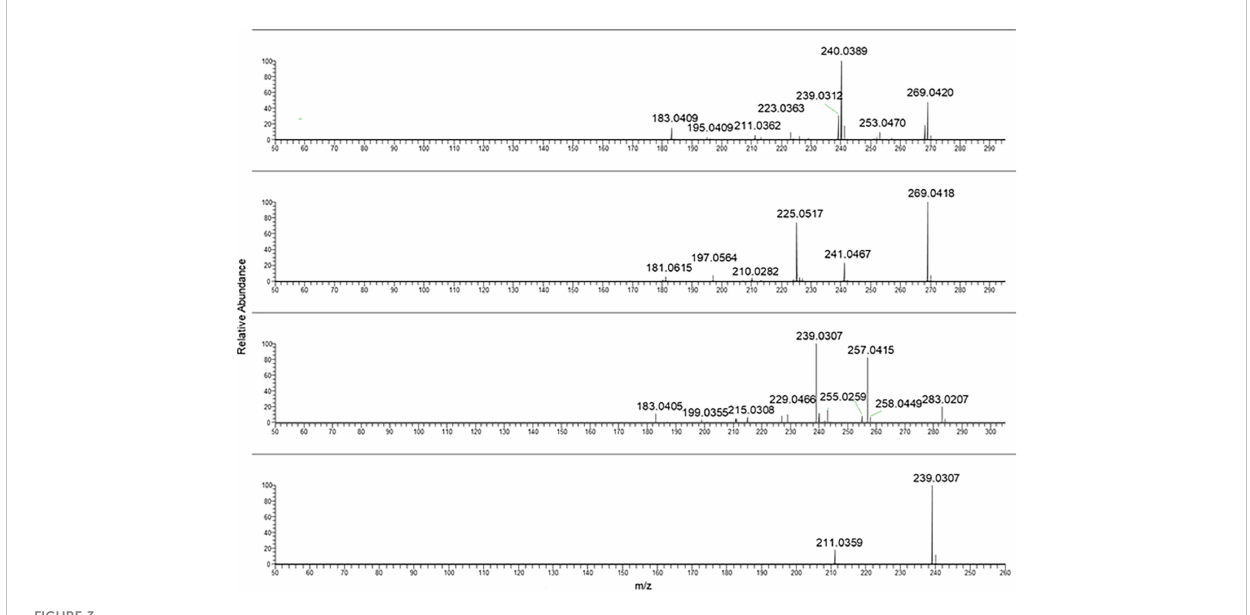
FIGURE 3 From the top to bottom: Aloe emodin, emodin, rhein and danthron MS/MS